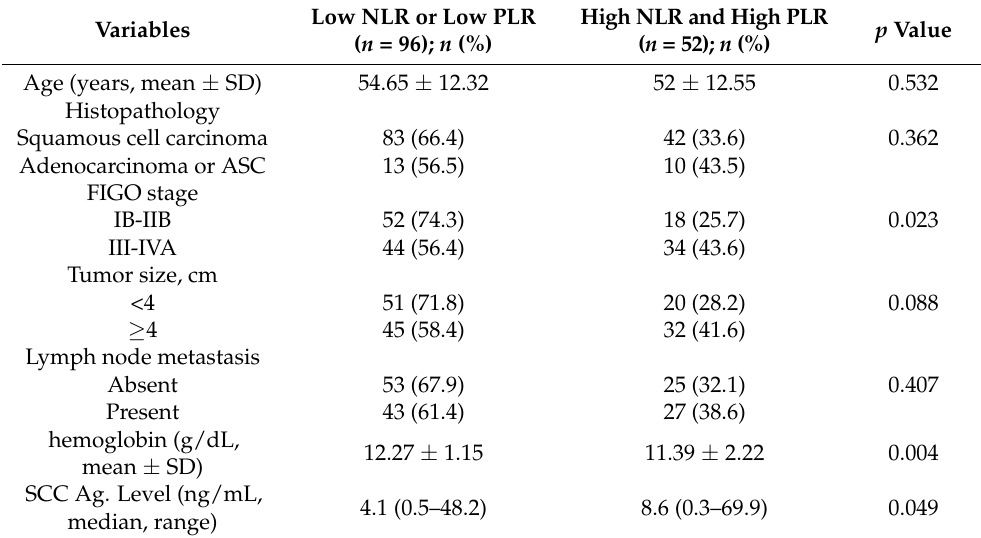
Table 2. Characteristics of patient and tumors according to NLR-PLR